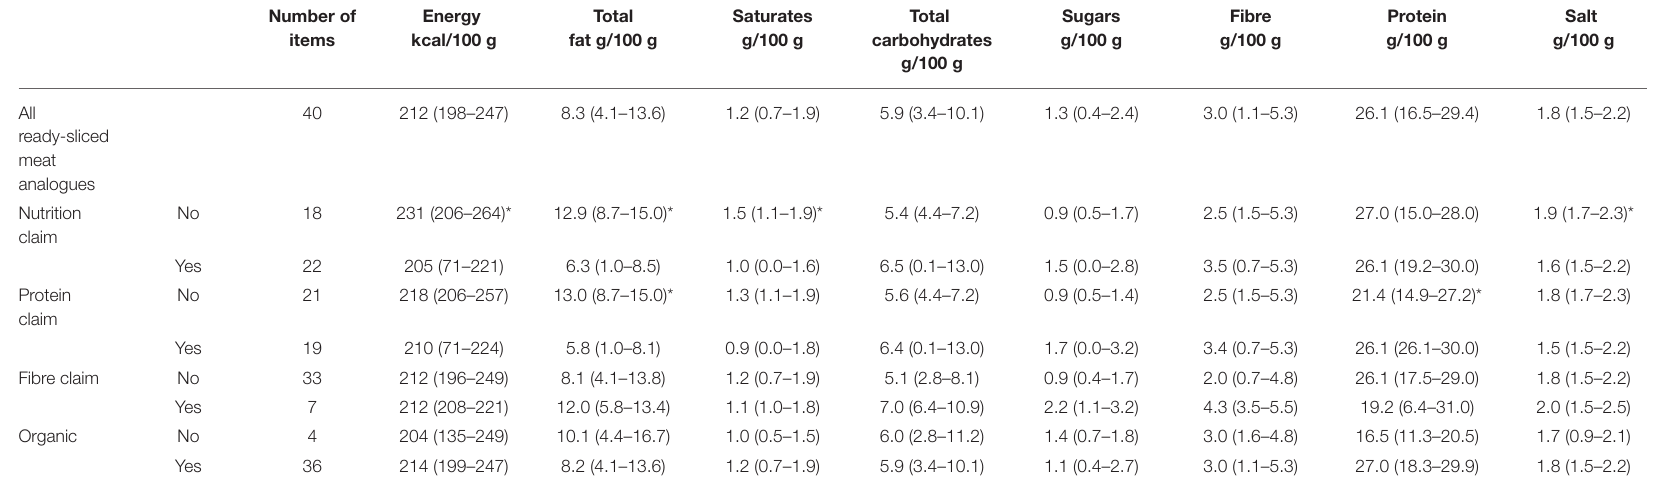
TABLE 2 | The number of items and nutrition declaration [according to the Council Regulation (EU) 1169/2011 (14)] of plant-based ready-sliced meat analogues reported for presence of nutrition claim and organic declaration.